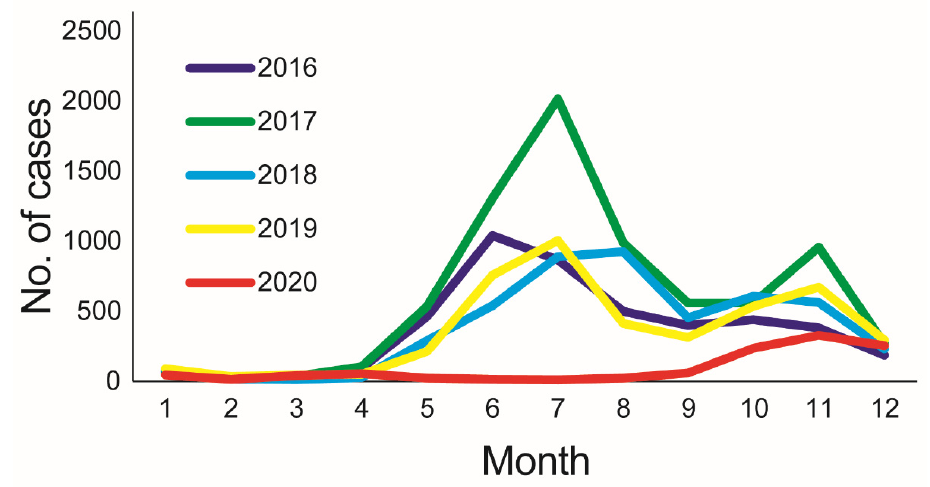
Figure 1. Monthly distribution of HFMD cases from 2016–2020.